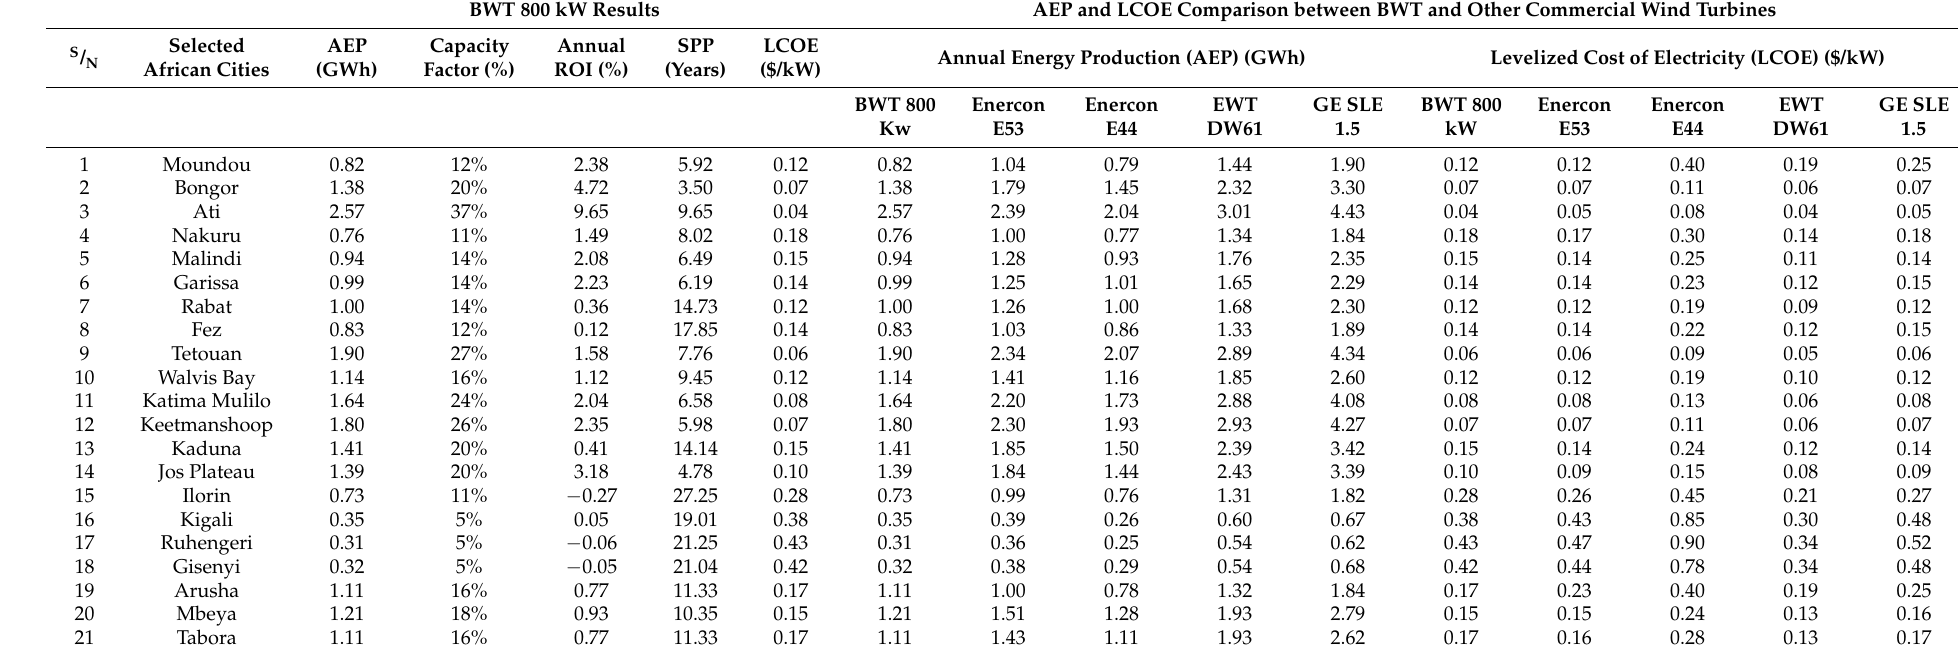
Table A3. Results of Intermediate